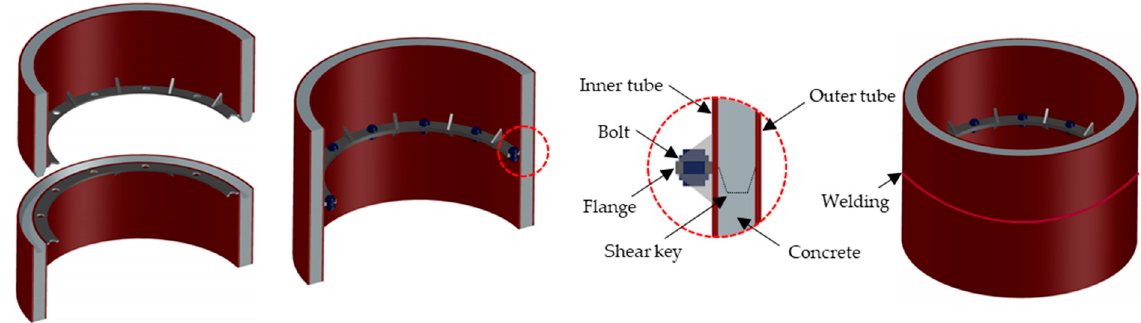
Figure 7. Bolting, welding, and shear key connector (Type-W).